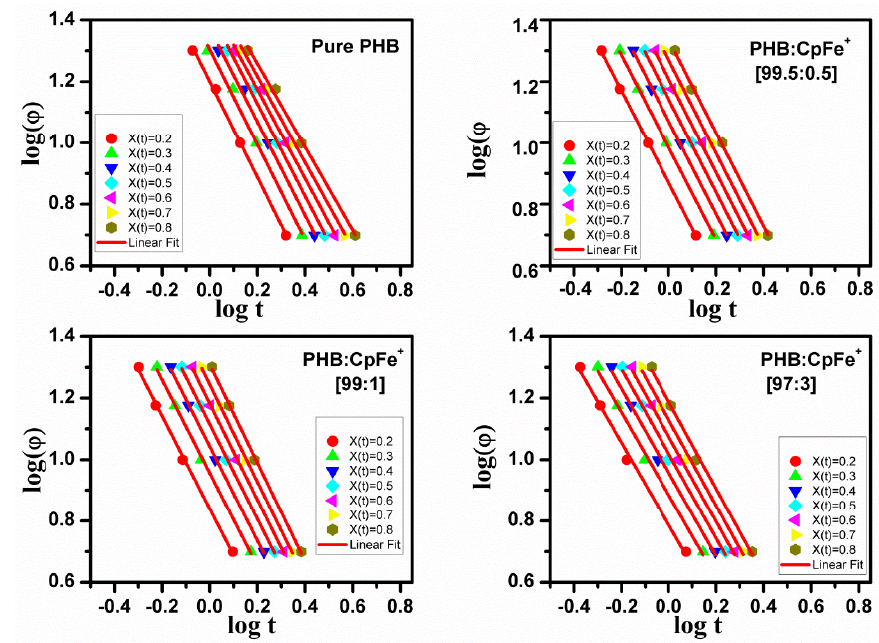
Figure 10. Plots of log(φ) versus log(t) for the pure PHB and PHB/CpFe + nanocomposites that non-isothermally crystallized at a given X(t). Table 4. F(T) and b values by MO approach for pure PHB and PHB/CpFe + nanocomposites.